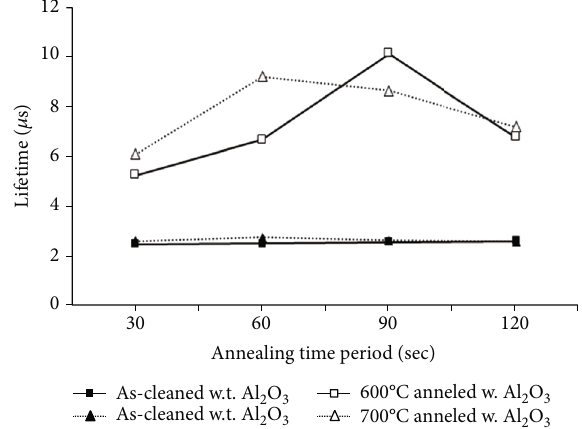
Figure 6: Lifetimes of bare wafers achieved at 600 ° C and 700 ° C for various annealing time periods. A maximum lifetime of 10.15 μ s occurred at 600 ° C for 90 O . 2 3